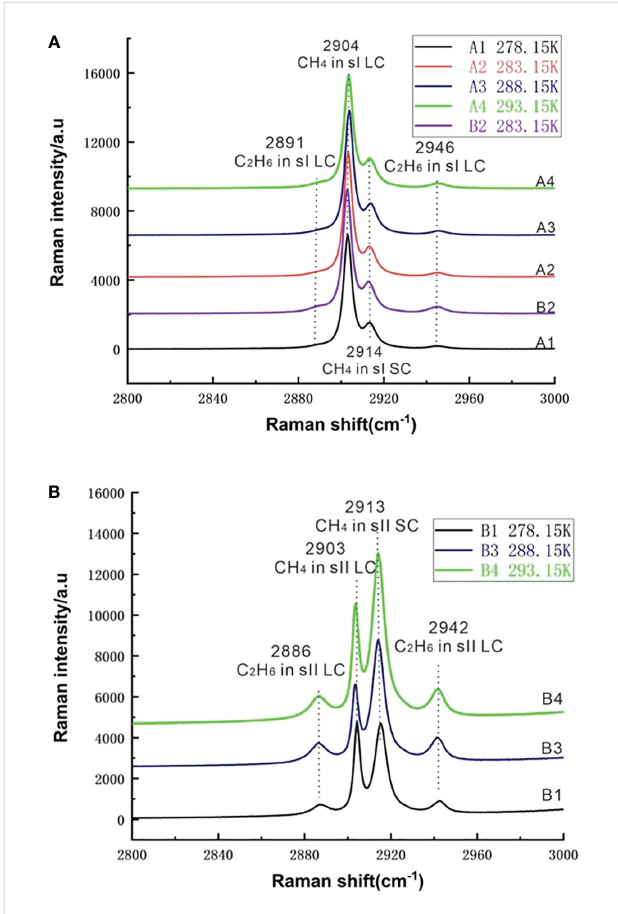
FIGURE 5 Raman spectra of the mixed gas hydrate samples in the regions between 2,800 cm – 1 and 3,000 cm – 1 . Sample number and corresponding experimental temperature are marked. (A) Raman spectra of the C – H region for structure I (sI) hydrate samples (A1, A2, A3, A4, and B2); and (B) Raman spectra of the C – H region for structure II (sII) hydrate samples (B1, B3, and